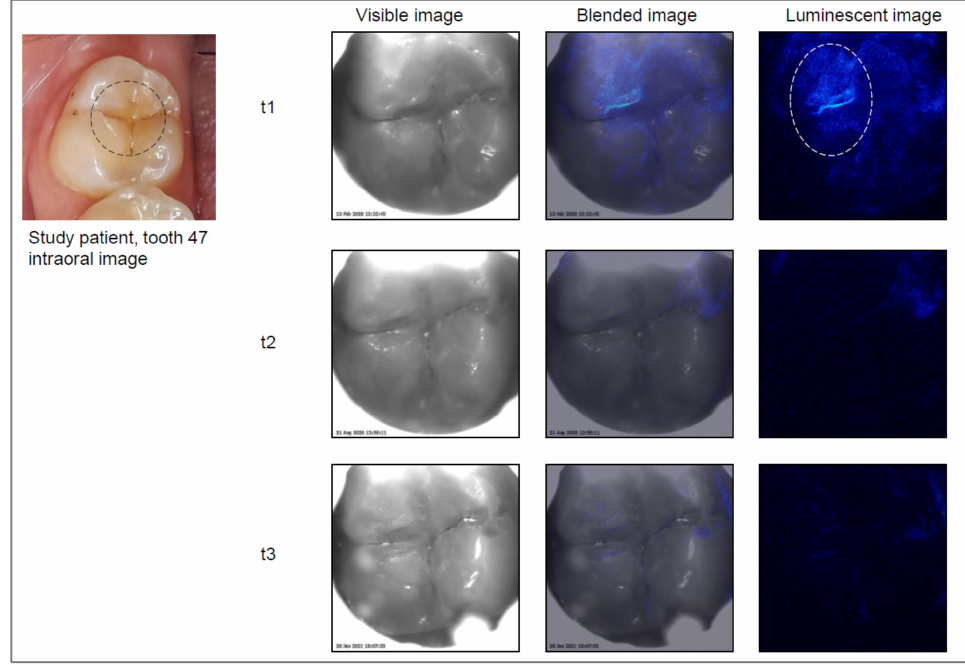
Figure 4. Example of a study tooth (lower right molar) with an active lesion at t1. At t2 and t3, the tooth was assessed visually as inactive. No bioluminescence signal is visible on the images at t2 and t3.